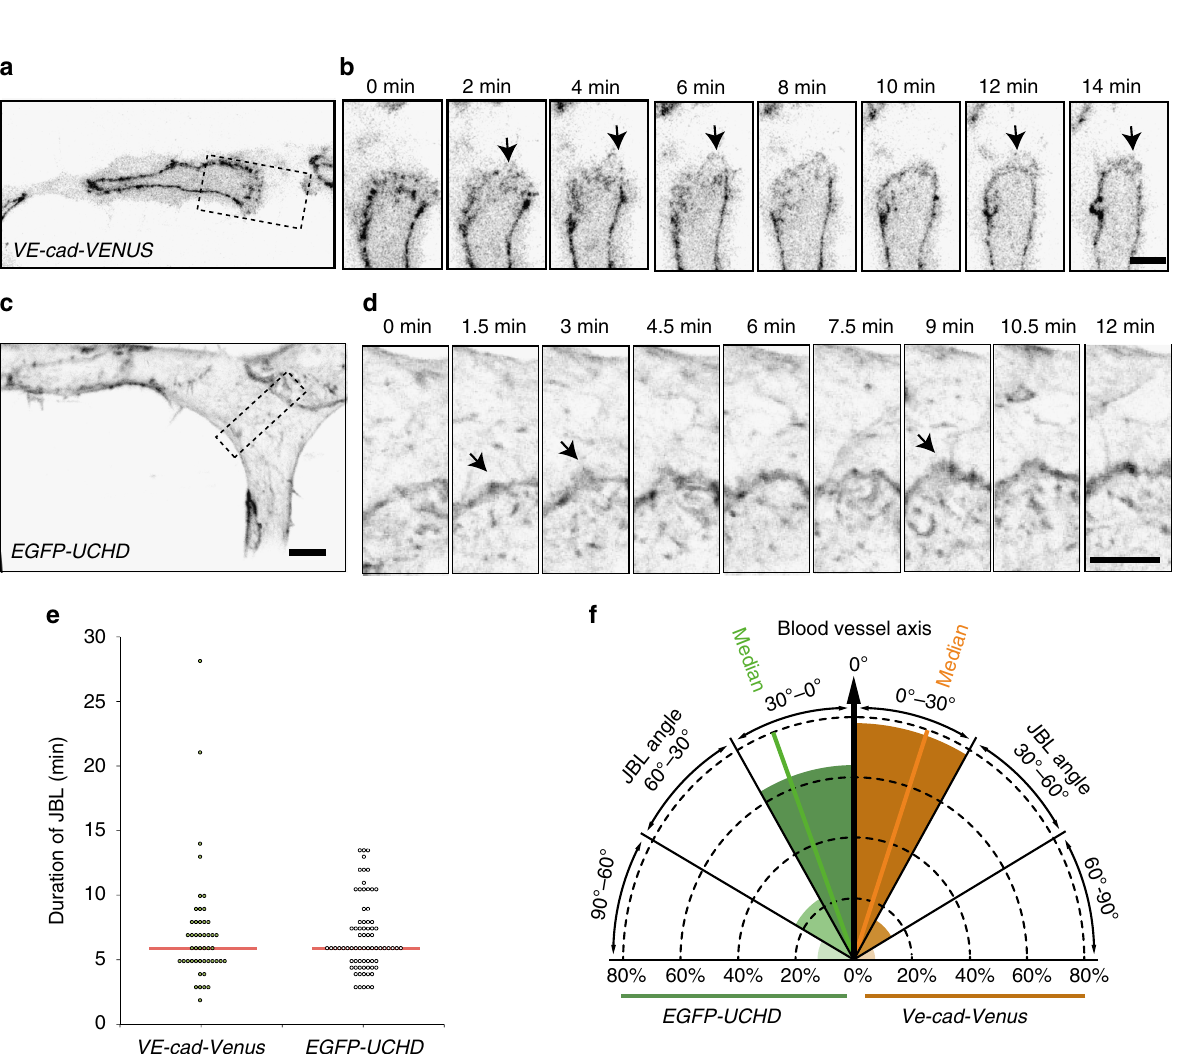
Fig. 2 Active VE-cad and F-actin behavior of junction-based lamellipodia. a , b Still images from a movie (Supplementary Movie 2) of a VE-cad-Venus expressing embryo Tg(BAC(cdh5:cdh5-ts)) , showing the DLAV at 30 hpf in inversed contrast. b A magni fi cation of the inset in a . Arrows point to JBL. c , d Still images from a movie (Supplementary Movie 3) of a EGFP-UCHD expressing embryo ( Tg( fl i:Gal4ff ubs3 , UAS:EGFP-UCHD ubs18 )) showing the DLAV at 30 hpf in inversed contrast. d A magni fi cation of the inset in c . Arrows point to JBL. e Scatter plot of quantitation of the duration of the JBL with the VE-cad-Venus transgene ( n = 48 in 6 embryos) and EGFP-UCHD movies ( n = 74 in 6 embryos), red line represents the median. f Quantitation of JBL angle in the DLAV in respect to the blood vessel axis (0°) using the EGFP-UCHD transgene ( n = 103 from 6 embryos) or Cdh5-Venus transgene ( n = 41 from 5 embryos). Scale bars 5 µ